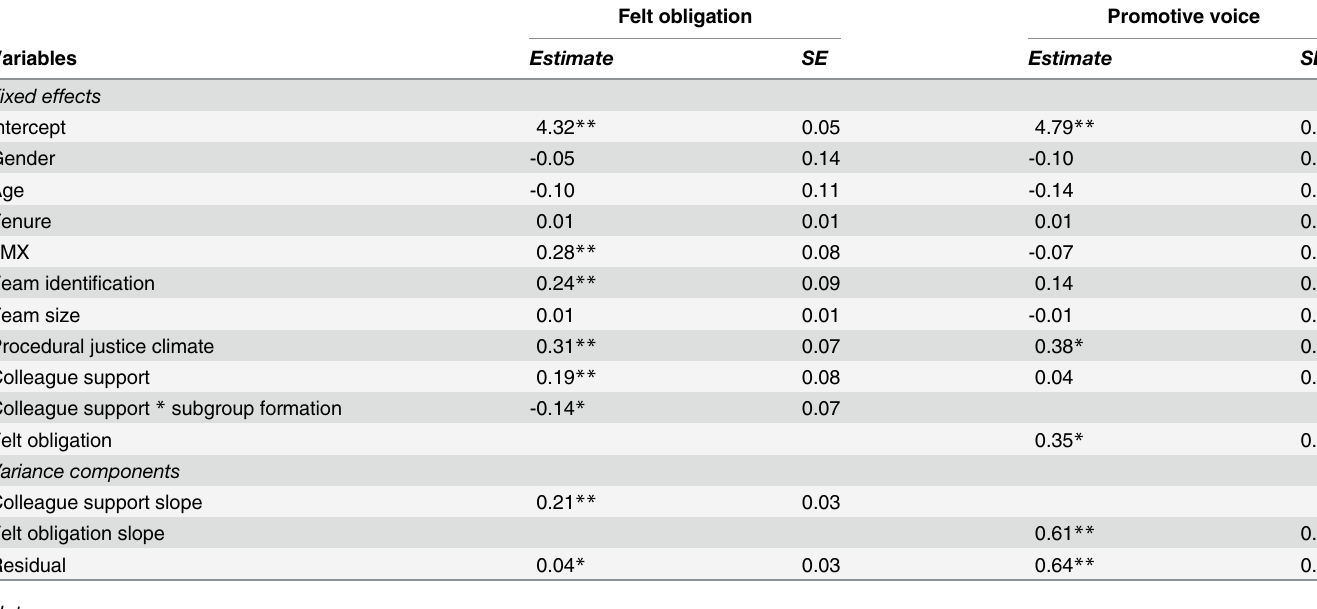
Table 3. Unstandardized coefficients of the multilevel